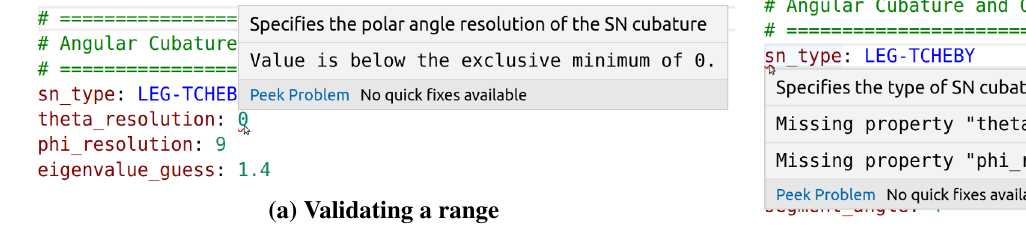
Figure 3: Validation in the PROTEUS YAML